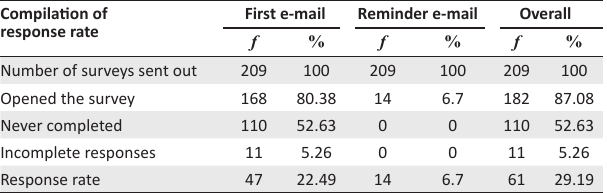
TABLE 2: Response rates for the